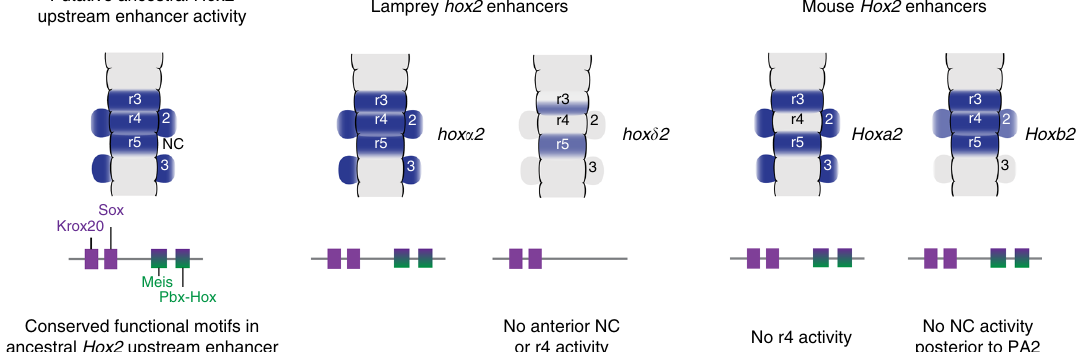
Fig. 8 Evolutionary model for regulation of Hox2 genes in vertebrates. a A model for evolution of the neural crest (NC) Hox code, based on our data. a NC gene regulatory network (GRN) and NC Hox -code evolved in ancestral vertebrates and are conserved between cyclostomes and gnathostomes. In ancestral vertebrates, Hox2 NC expression was regulated by TALE (Three-Amino-Acid-Loop-Extension) and Hox factors, through a putative ancestral enhancer with shared NC and hindbrain activities. b A model for the divergence of lamprey and mouse Hox2 NC/hindbrain enhancers. Enhancer activity domains are depicted in blue in schematic dorsal views of the hindbrain and pharyngeal arches. Conserved functional motifs (Krox20, Sox, Meis, Pbx-Hox) present upstream of lamprey and mouse Hox2 genes are shown. Lamprey and mouse enhancers show divergent activities. Comparison between expression domains and conserved motifs leads us to suggest that a putative ancestral vertebrate Hox2 enhancer contained cis -elements for r3/r5 expression ( Krox20 , Sox ) and r4/NC expression ( Meis , Pbx-Hox ).These scenarios assume that duplication events that gave rise to four Hox clusters in early vertebrates occurred prior to the cyclostome/gnathostome split, as the most parsimonious explanation 22,81 . However, it is also possible that independent genome duplication events may have occurred in cyclostome and gnathostome lineages (see Holland and Ocampo Daza 82 for a recent